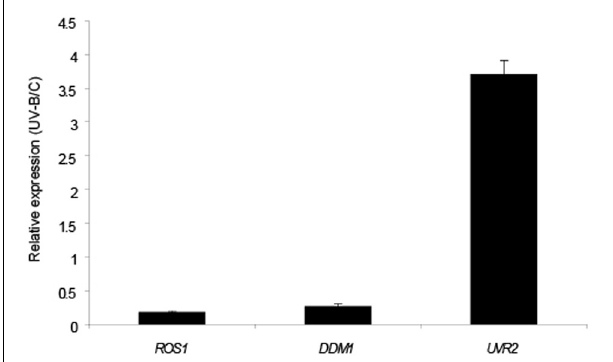
FIGURE 2 | Relative transcript levels of A. thaliana ROS1 and DDM1 genes measured by qRT-PCR. Plants were irradiated with UV-B light for 4h (UV-B) or kept under control conditions (C) as indicated in Materials and Methods. CPK3 transcript was used for normalization and UVR2 as a control of a UV-B inducible gene. Data show mean values ± S.E.M. of at least three independent